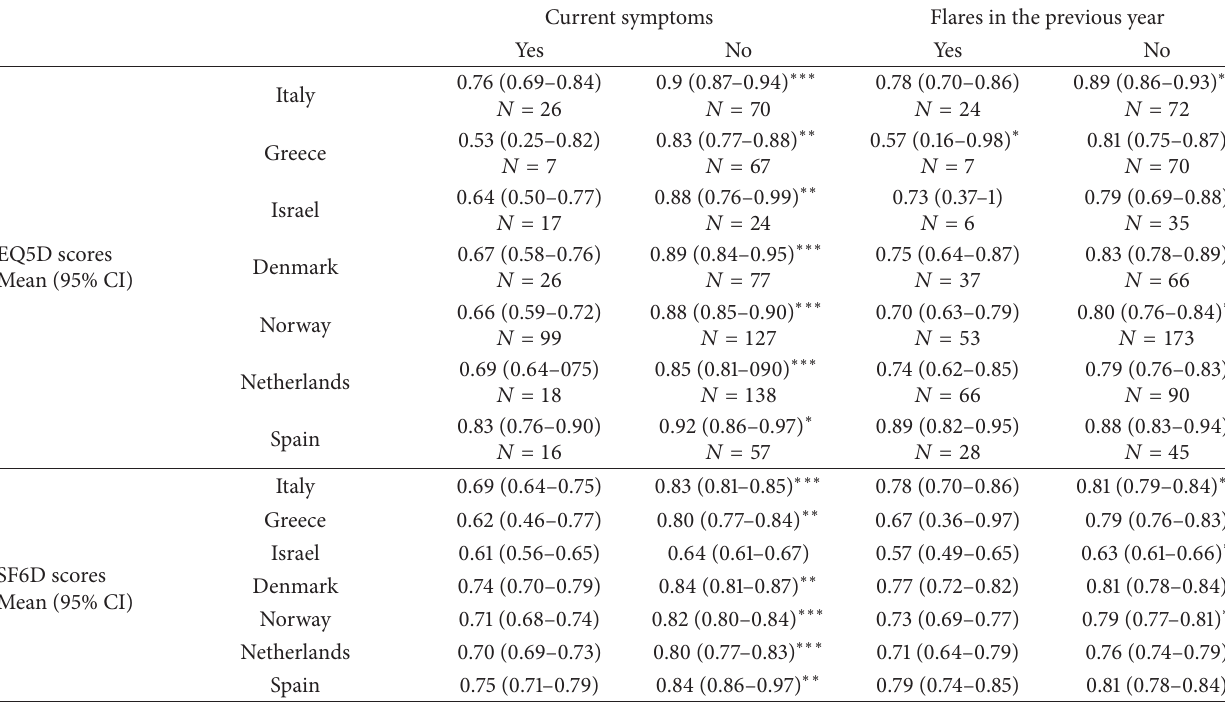
Table 5: EQ-5D and SF-6D index scores and subjectively perceived disease activities stratified by countries. Current